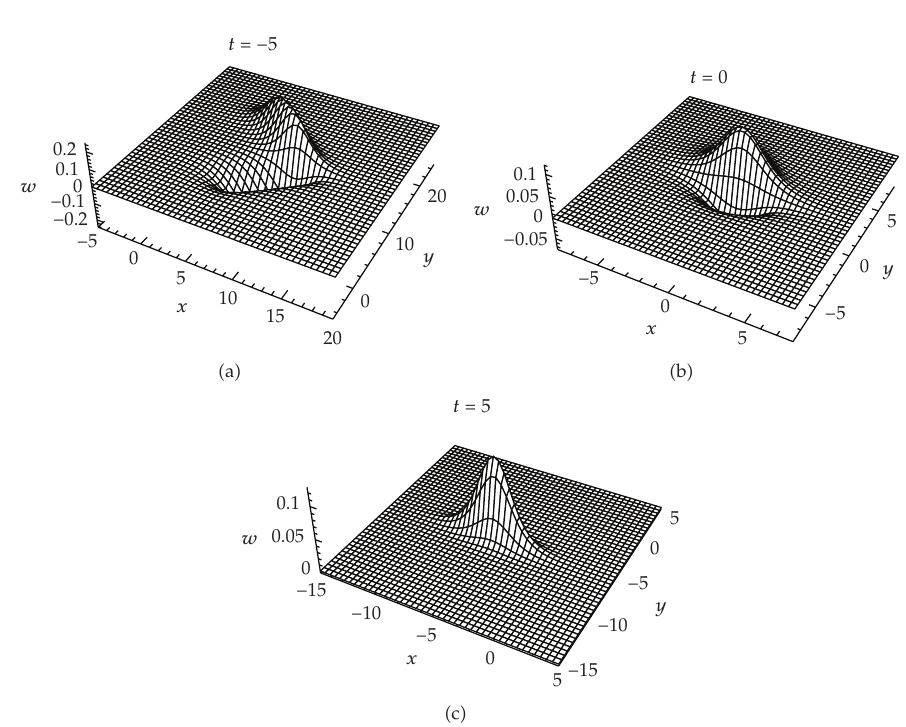
Figure 4: The fussion phenomenon of two dromions-like for (cid:2) 4.9 (cid:4)